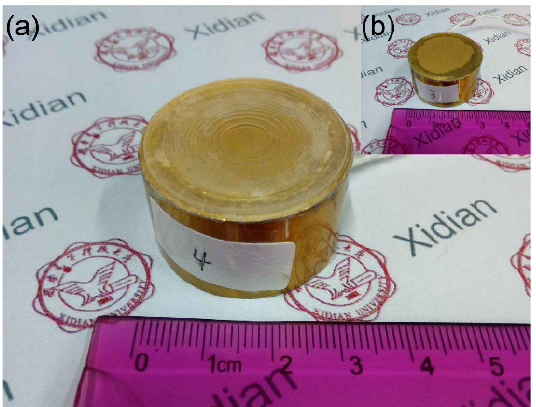
Figure 5. ( a ) Transducer with Fresnel lens and ( b ) without Fresnel lens.